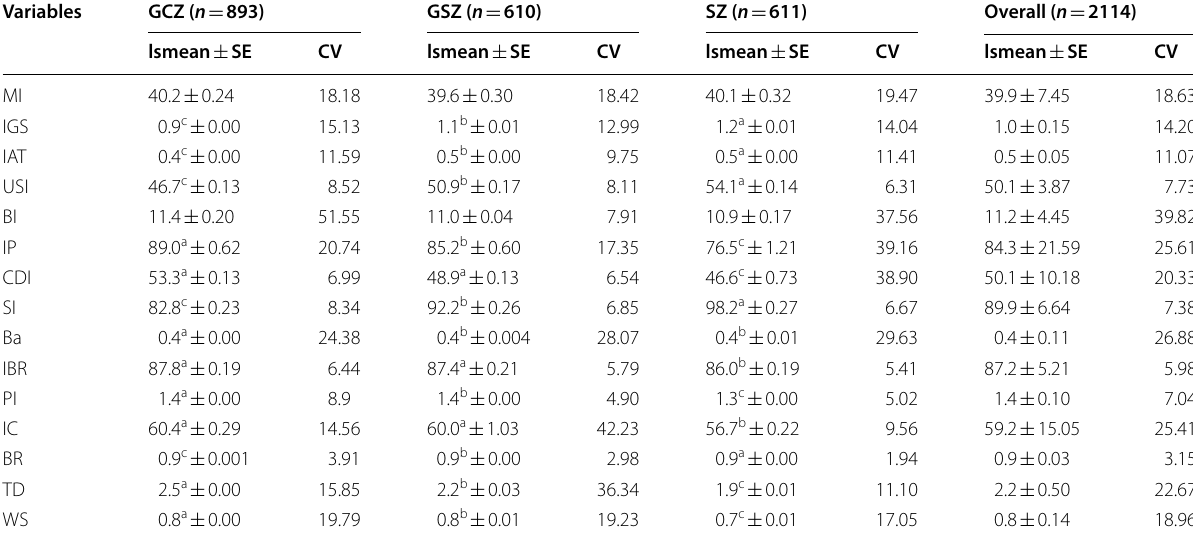
Table 2 Least squares means (lsmeans) and standard errors (SE) and coefficients of variation (CV) of morphological indices across vegetation